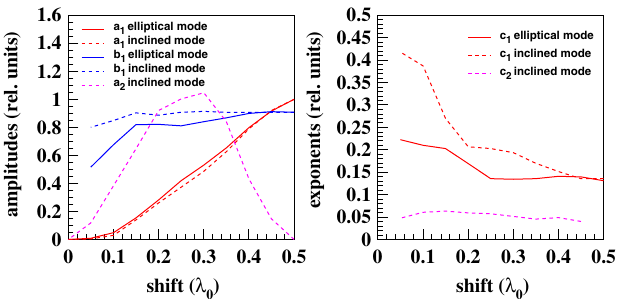
FIG. 8. Parameters of the L -shim model depending on the row phase. The parameters are given for the UE112 at a reference gap of 20